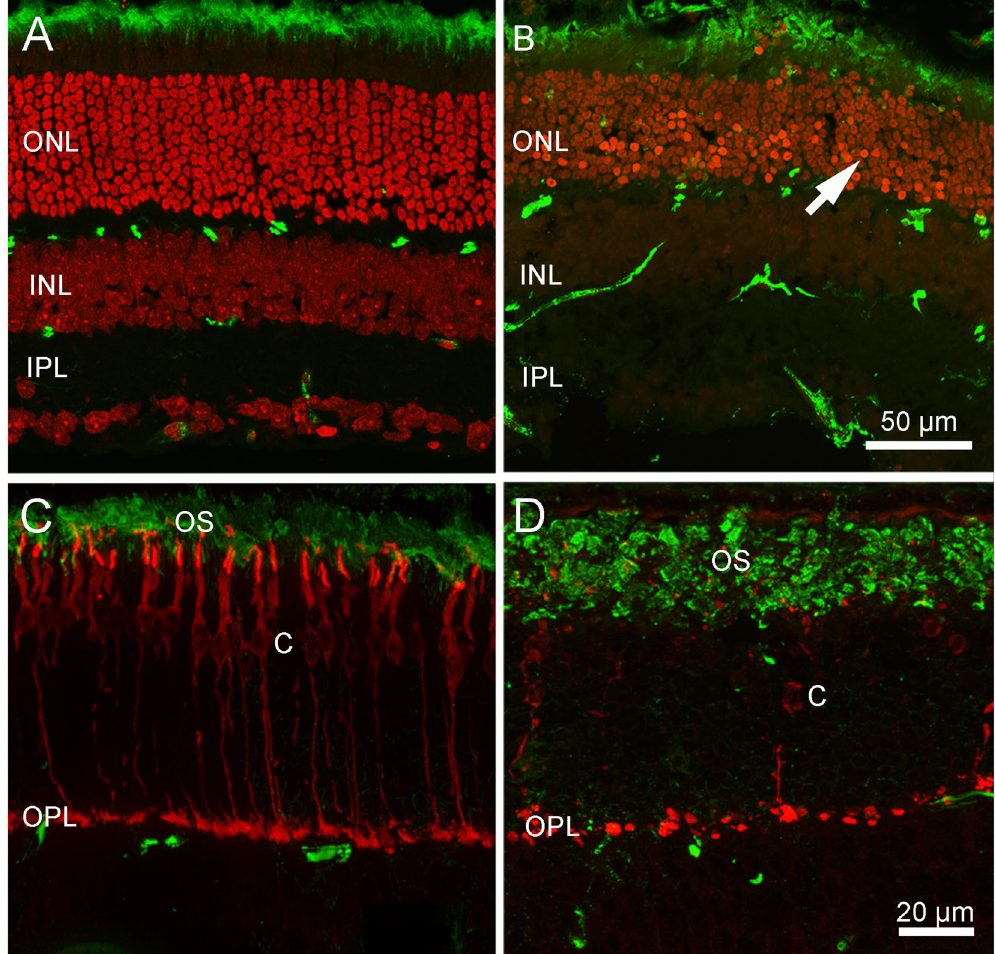
Figure 1. Early effects of bright light exposure. ( A , C ) Control retinas from Ht Tvrm4 mice before bright light exposure; ( B , D ) Central retinal sections from Ht Tvrm4 littermates exposed to 12,000 lux for 1 min and examined after 48 hrs. ( A , B ) Green signal: ICCH for the light sensitive channel of rods; red: ethidium nuclear counterstaining. Note the thinner ONL and the abundance of pycnotic nuclei in ( B ) (arrow). ( C , D ) cone arrestin (red) and rhodopsin (green). Clustering of rhodopsin in the outer segments of rods (OS) is evident in ( D ) where cones are also poorly stained and at a lower